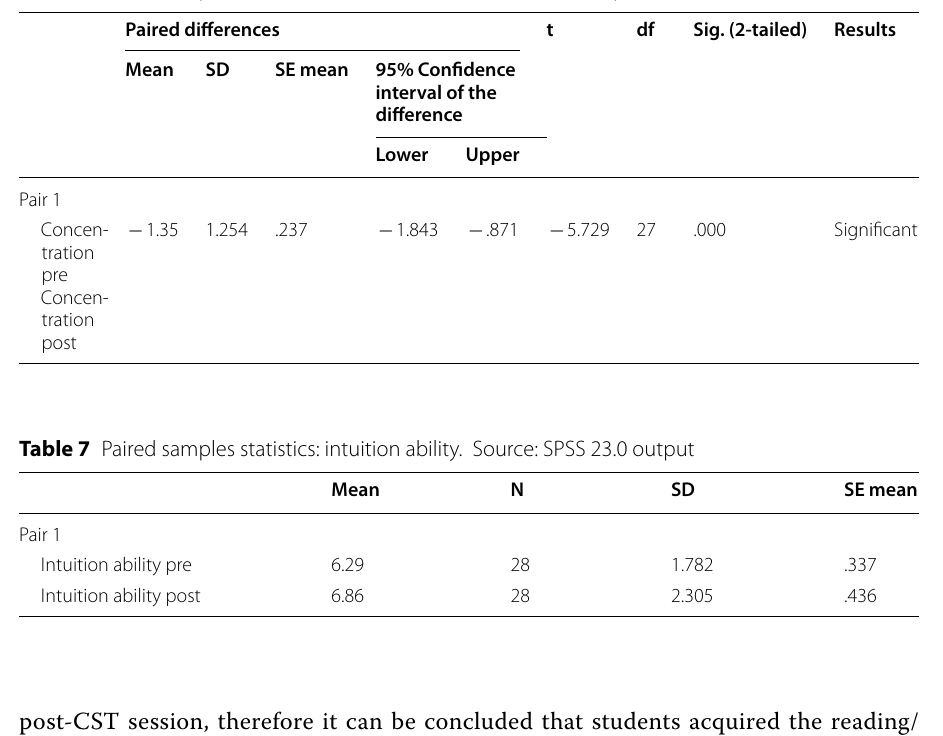
Table 6 Paired samples test: concentration. Source: SPSS 23.0 output Paired differences t df Sig. (2-tailed)